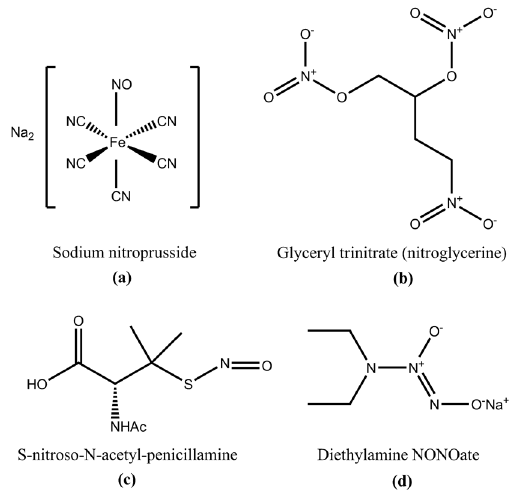
FIGURE 1 - Representative NO-donors: (a) metal nitrosyl, (b) organic nitrates, (c) S-nitrosothiols and (d)